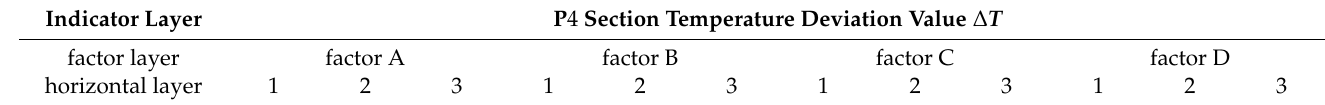
Table 9. Data structure model hierarchy